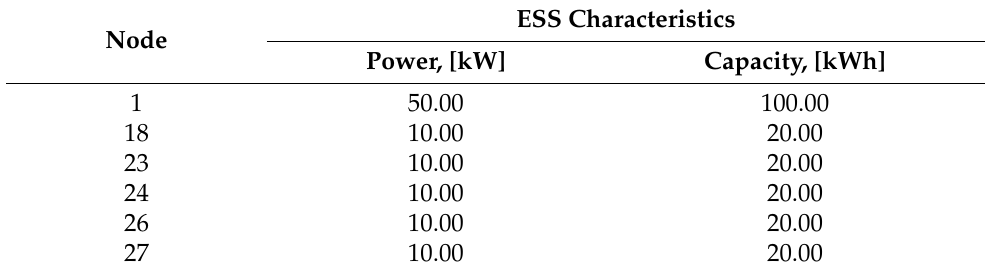
Table 6. Characterization of ESS.